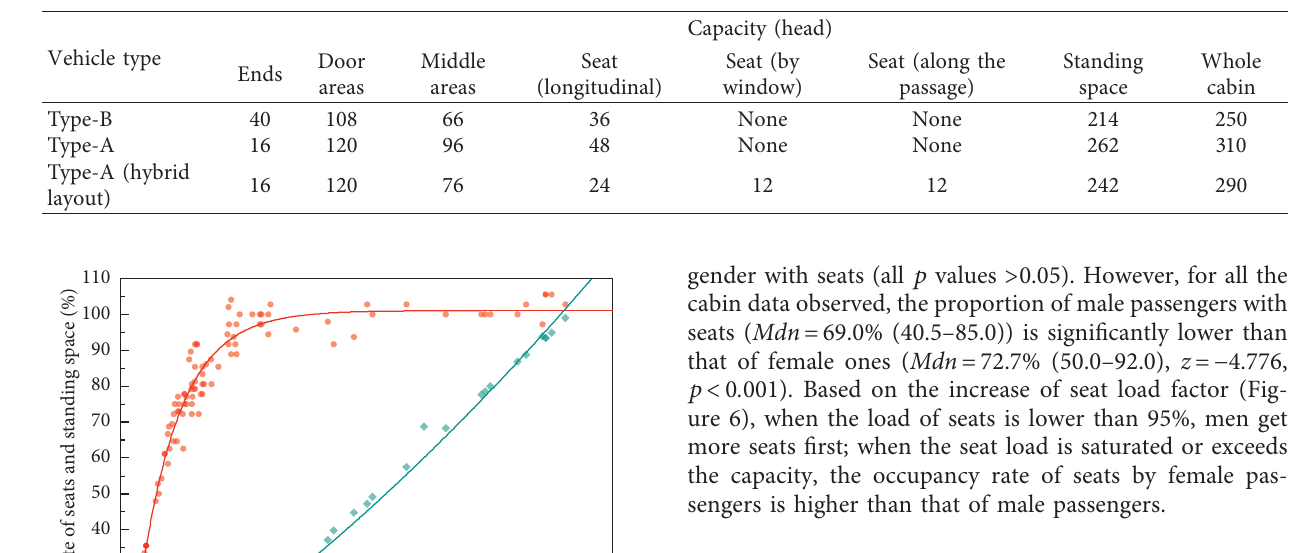
Table 3: Capacity of the cabin.